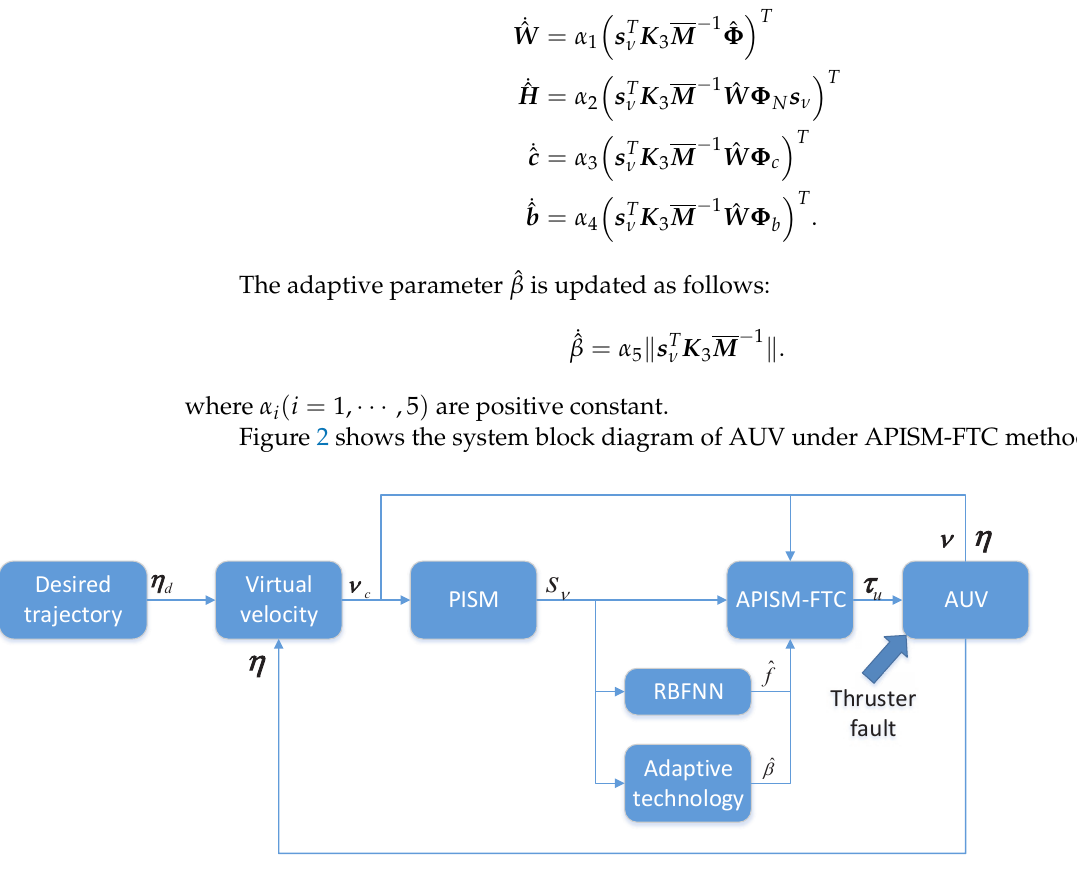
Figure 2. System block diagram of AUV under APISM-FTC